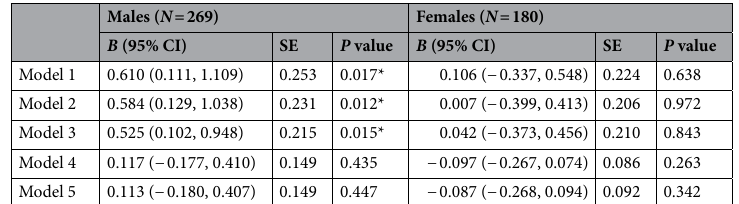
Table 3. Longitudinal associations between depressive symptoms and pericardial fat adjusted for body surface area. SE = robust standard errors to adjust for heteroscedasticity. * p < 0.05, ** p < 0.01, *** p < 0.001. Model 1 adjusted for age and grade of employment. Model 2 adjusted for age, grade of employment and waist to hip ratio. Model 3 adjusted for age, grade of employment, waist to hip ratio, smoking, LDL cholesterol, HDL cholesterol, triglycerides, systolic blood pressure and HOMA-IR. Model 4 adjusted for age, grade of employment, waist to hip ratio, smoking, LDL cholesterol, HDL cholesterol, triglycerides, systolic blood pressure, HOMA-IR and baseline levels of pericardial fat. Model 5 adjusted for age, grade of employment, waist to hip ratio, smoking, LDL cholesterol, HDL cholesterol, triglycerides, systolic blood pressure, HOMA-IR, baseline levels of pericardial fat and IL-6. CI confidence interval, HDL high-density lipoprotein, HOMA-IR insulin resistance, LDL low-density lipoprotein, IL-6 interleukin-6.